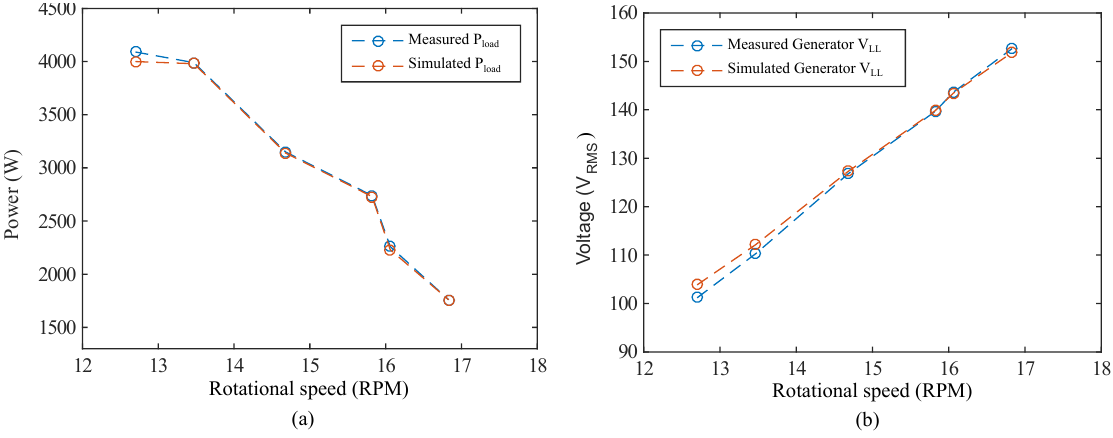
Figure 5. Calibration of the generator model using AC-load operation; ( a ) Power in the load; ( b ) Generator line-to-line